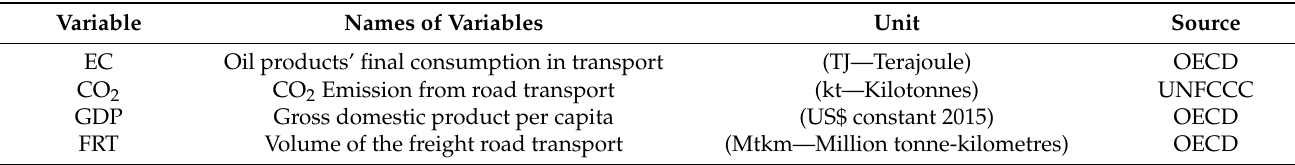
Table 1. Type, measurement units and sources of data used in the